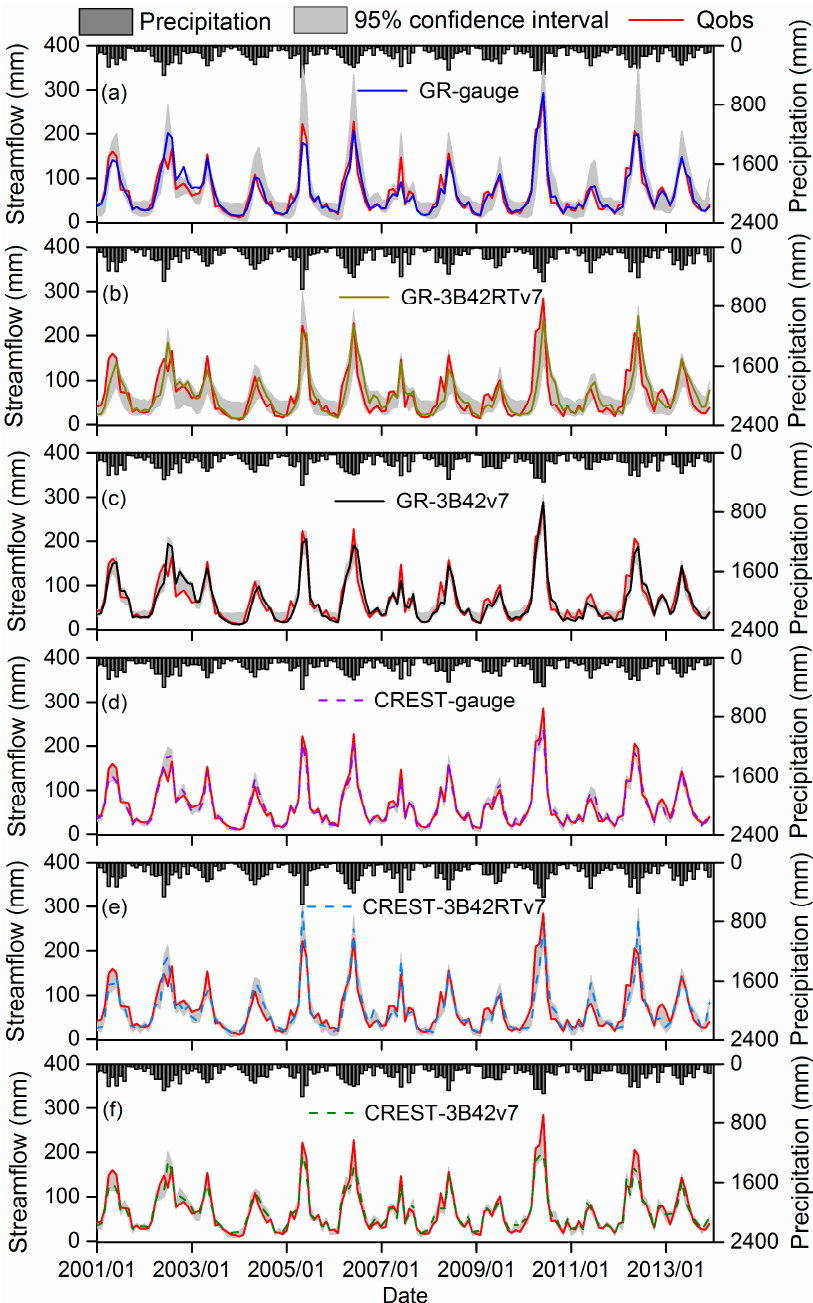
Figure 6. The 95% confidence intervals of the ensemble output for discharge of two models in three precipitation input scenarios. Qobs represents the observed discharge.